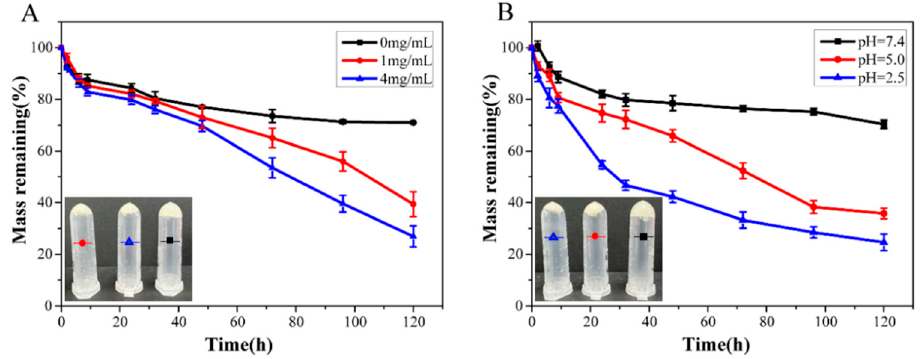
Figure 4. The degradation of hydrogels at different glucose levels ( A ) and pH ( B